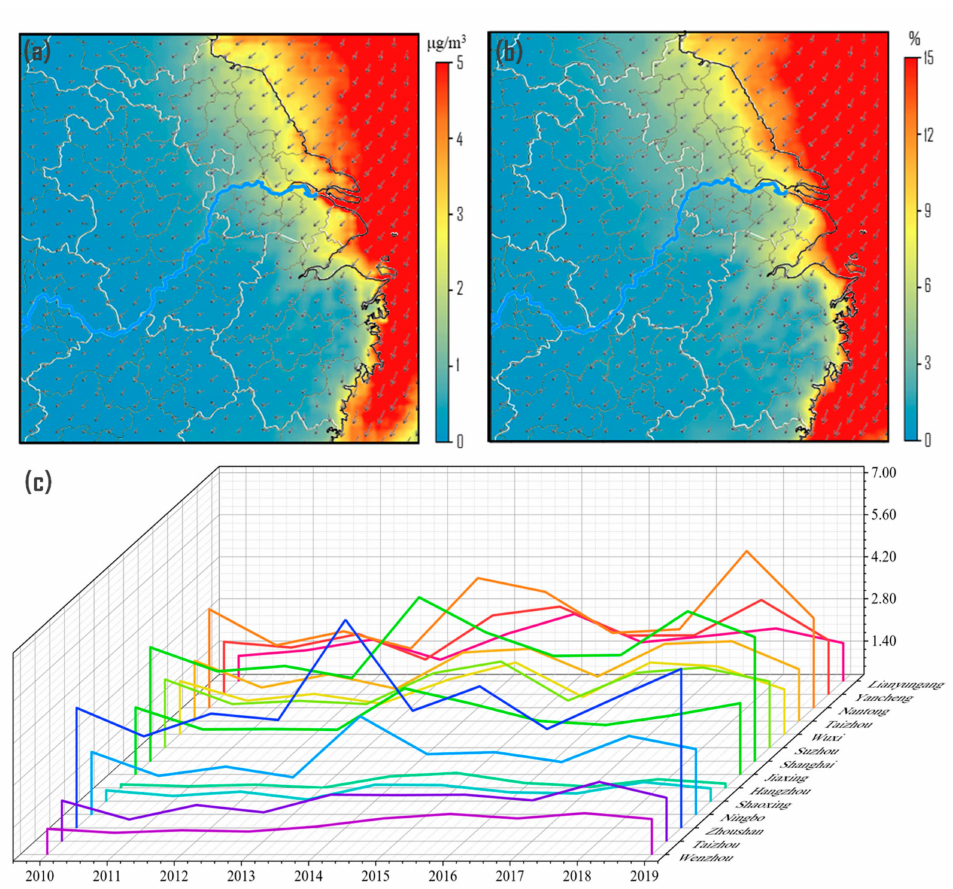
Figure 3. The 10-year average contribution of ship emissions to PM 2.5 overlapped by wind vectors in µ g/m 3 ( a ) and in % ( b ) over YRD region, and the inter-annual variation of the contribution in 14 coastal cities from 2010 to 2019 ( c